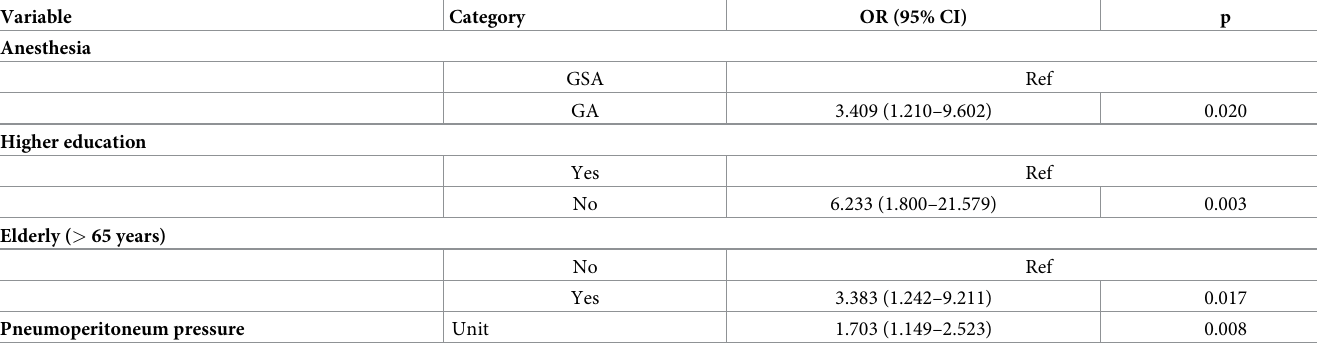
Table 5. Parameters estimates from multiple logistic regression models of delirium outcome.